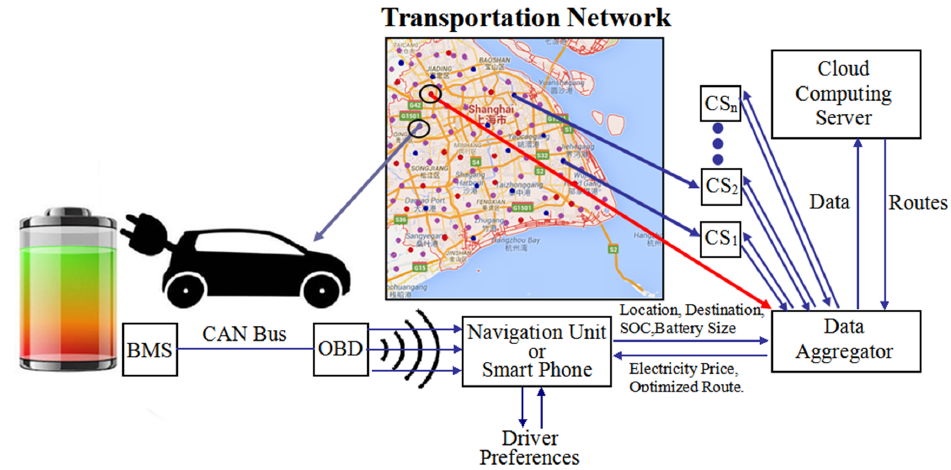
Figure 5. Least cost optimal routing strategy for EVs considering charging stations with different price incentives. BMS: battery management system; CAN: control area network; OBD: on board diagnostics .